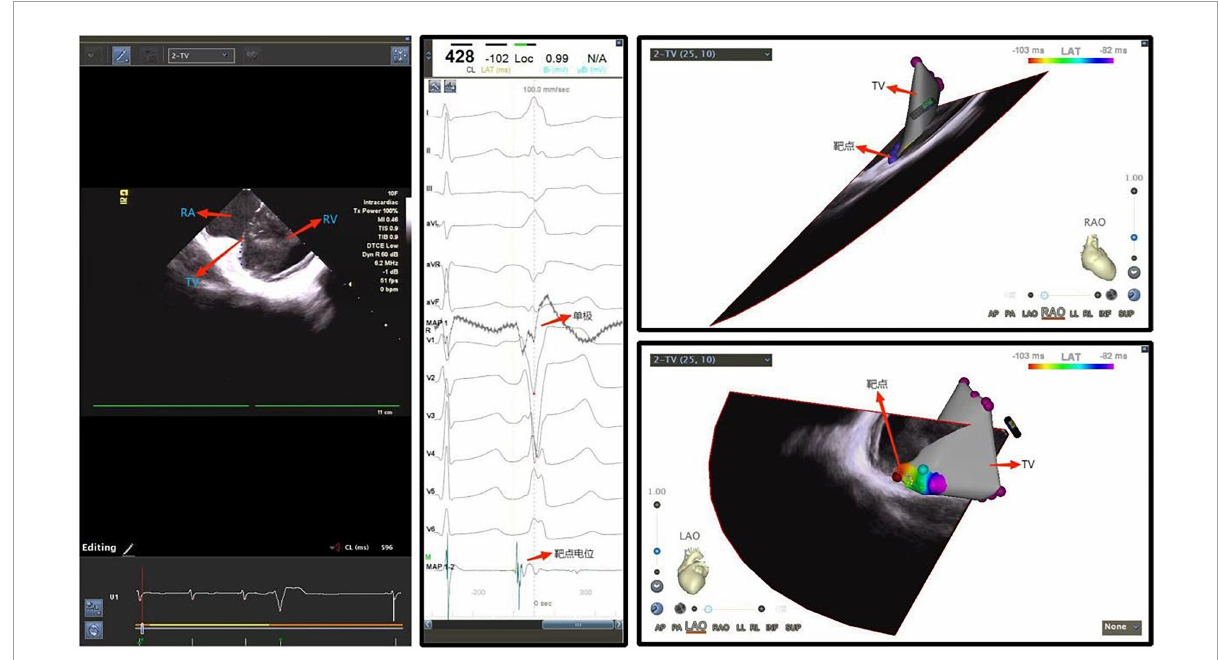
FIGURE7 Ventricular premature beat originating from the tricuspid annulus. RA, right atrium; TV, tricuspid valve; RV, right